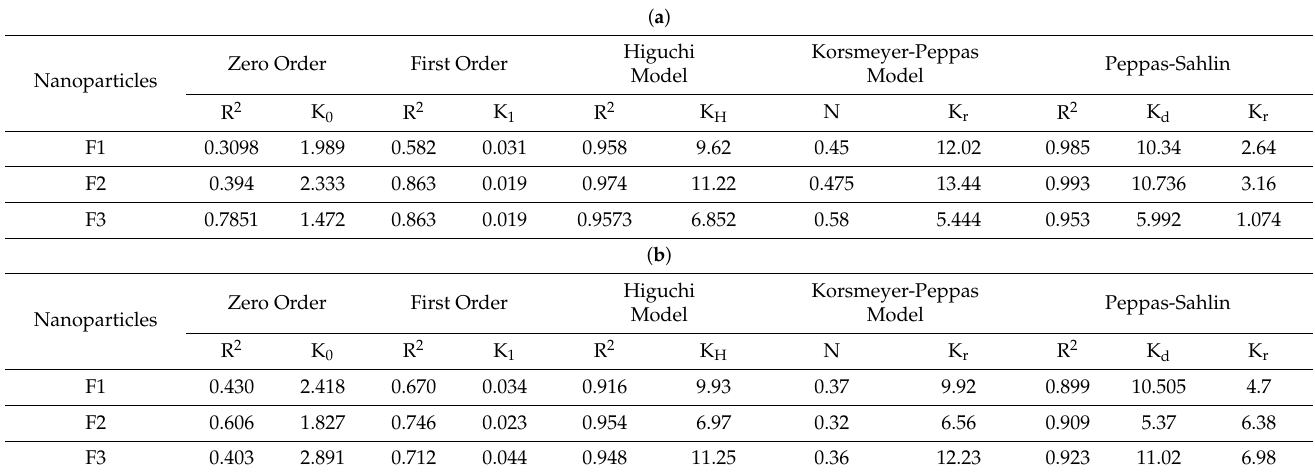
Table 4. ( a ): Modelling and release kinetics of nanoparticles at pH 5.5. ( b ): Modelling and release kinetics of nanoparticles at pH